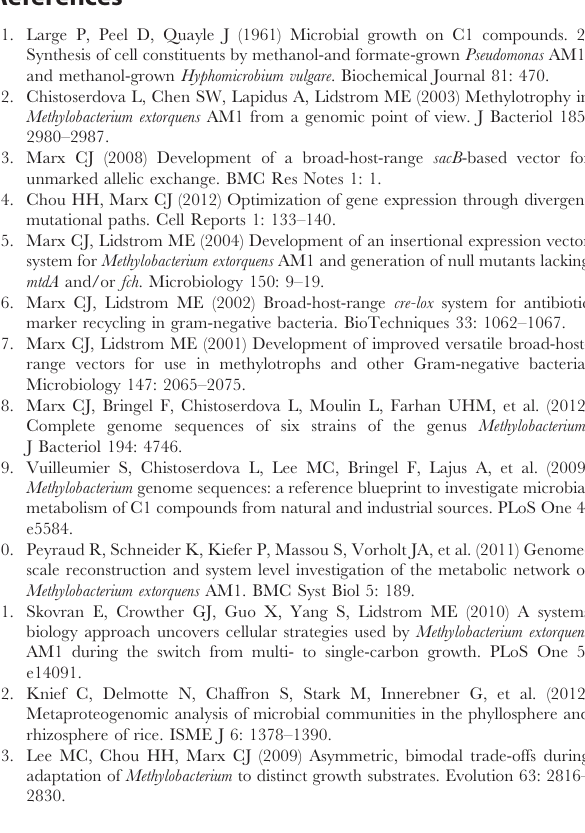
Figure S1 OD through time for AM1 D cel grown in a 96- well plate on MP media with succinate. Readings were taken approximately every 50 minutes. Figure S2 Comparison of the growth rates on different pH buffers. Shown are AM1 D cel and PA1 D cel , grown on one of two substrates (methylamine or succinate) with either PIPES or Phosphate used as a buffer at one of two concentrations. Red symbols indicate 48 mM buffer concentration and black symbols indicate 30 mM buffer concentrations of both PIPES and Phosphate buffered media. Initial pH of all media formulations was 6.7. Figure S3 Precipitates and growth readings in Choi medium. A) The bottom of Falcon tubes containing 6 ml of either Choi medium (not centrifuged, green) or MP medium (red).